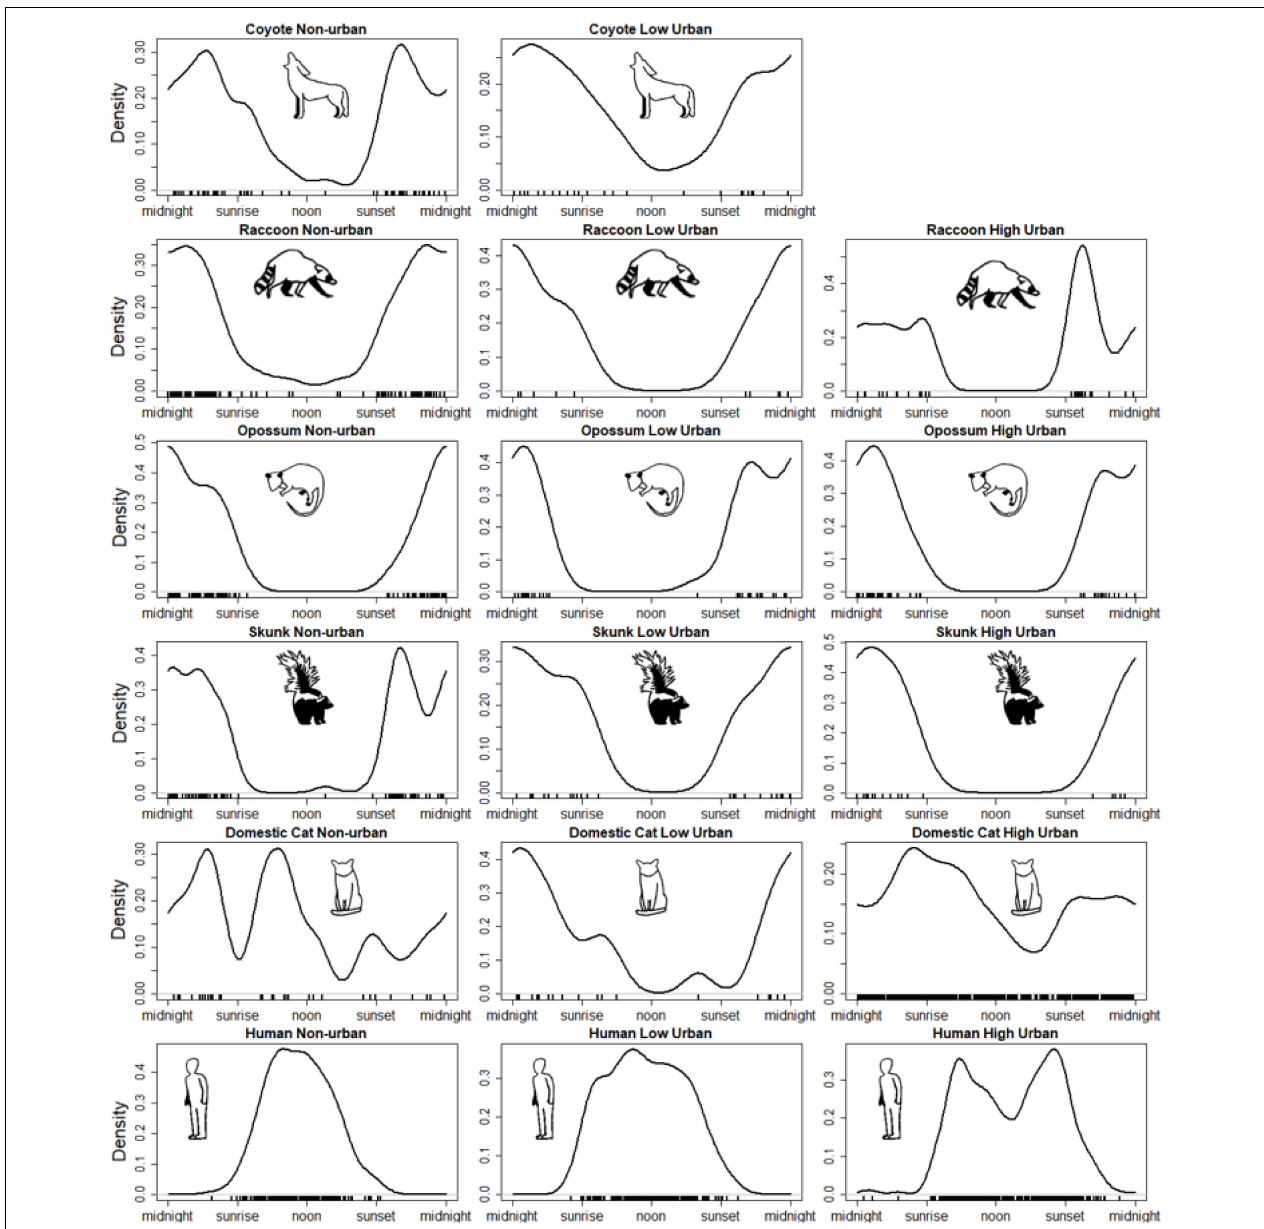
FIGURE 4 | Temporal activity patterns for species across urban intensity groups (non-urban, low intensity urban, high intensity urban). Plots are scaled from a 24-h clock to sun-time to account for daylight from sunrise to sunset. Black tick marks at the bottom of each plot indicate when species were